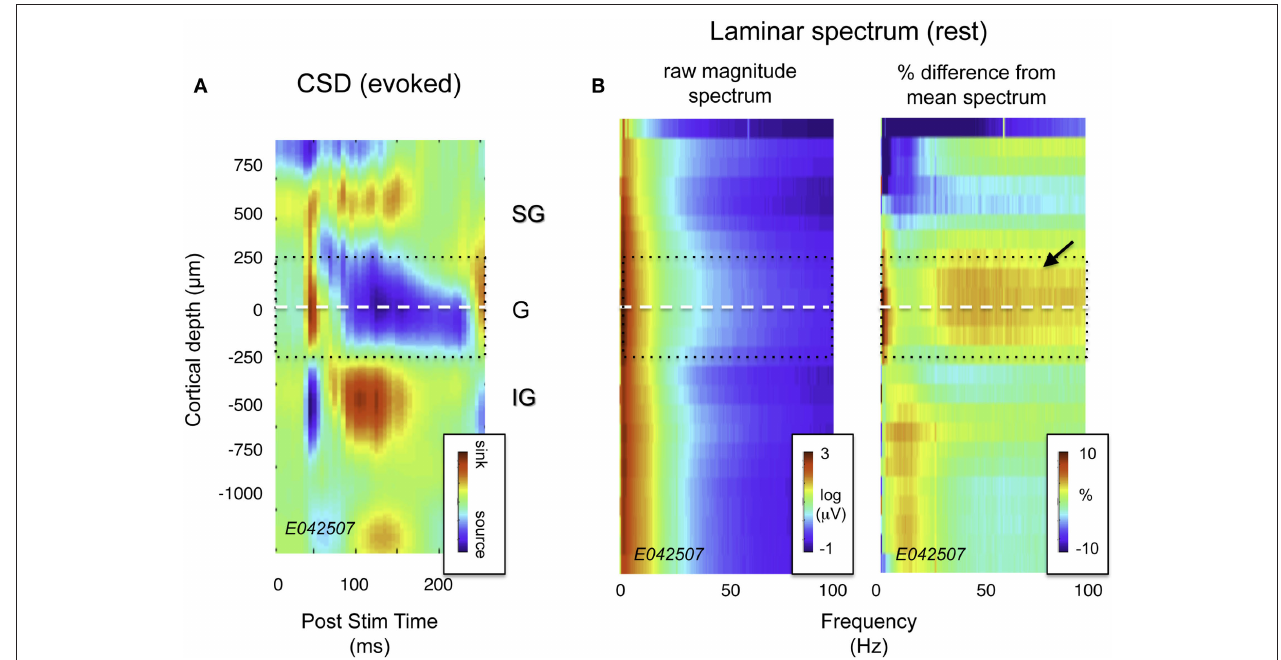
magnitude for a representative 20-min period following the CSD experiment with the monkey at rest. Signal magnitude is color-coded on a log scale, and plotted as a function of frequency and cortical depth. On the right is the same data, normalized by the mean spectrum across all layers, and expressed as percent deviation from this mean. Note the elevated LFP magnitude in the granular and deep supragranular layers (arrow). This feature proved highly consistent across sessions (see Figure 3A ).